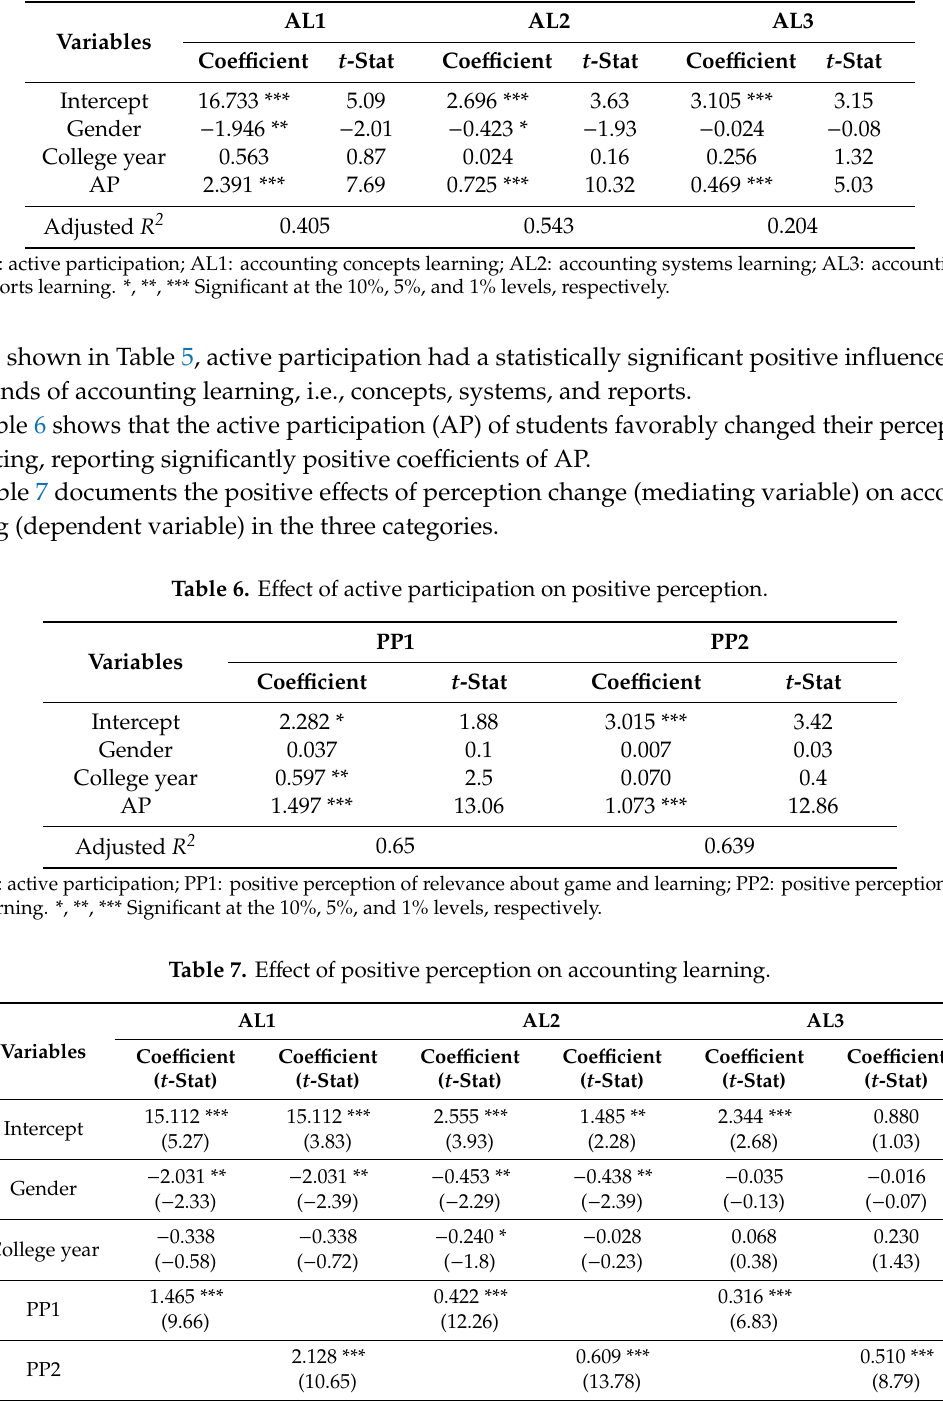
Table 5. E ff ect of active participation on accounting learning.